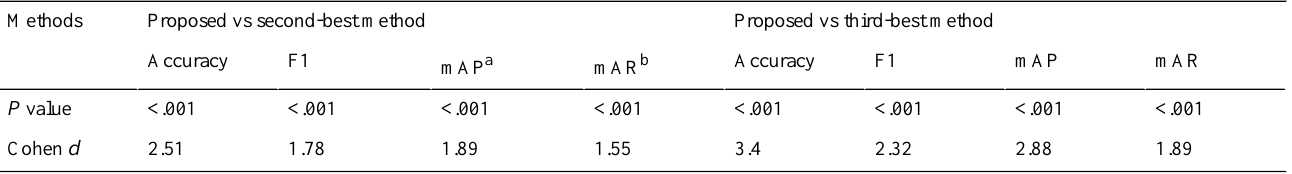
Table 3. The t test and Cohen d performance analysis results ( P values and effect